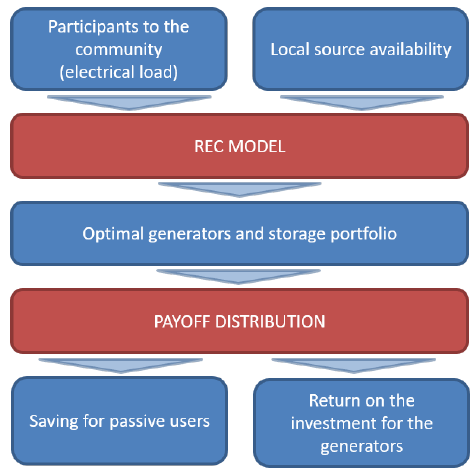
Figure 1. Flowchart of the proposed